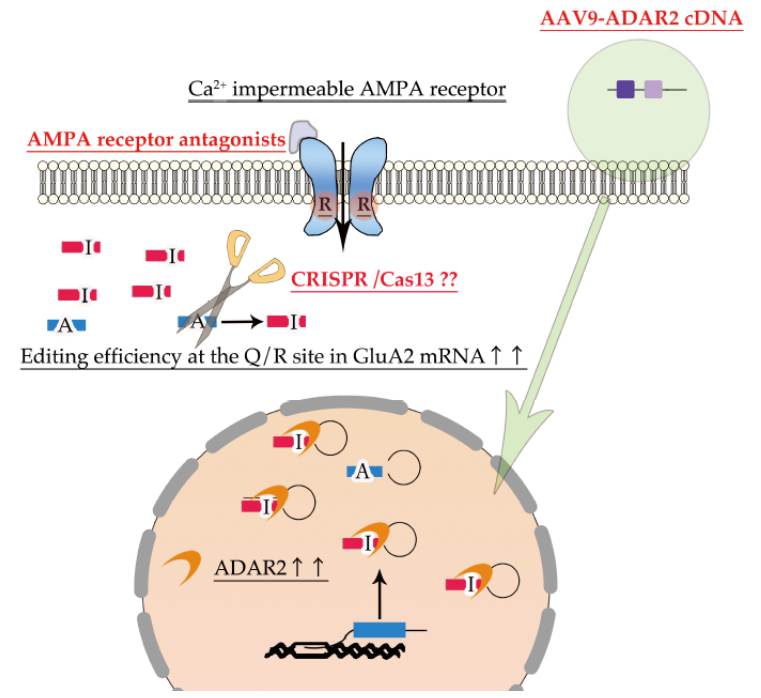
Figure 4. Promising therapy targeting dysregulation of ADAR2 RNA editing. AMPA receptor antagonists are potential therapeutic drugs for normalizing excessive Ca 2+ influx through Ca 2+ -permeable AMPA receptors. Delivery of ADAR2 cDNA to motor neurons using the adeno-associated virus type 9 (AAV-9) vector is a therapeutic approach to improve the expression of ADAR2 in the degenerating neurons (green arrow). Furthermore, RNA base editing of unedited GluA2 using CRISPR-Cas13 could also be a potential therapeutic approach to increase the proportion of edited GluA2. As RNA base editing therapy have not been established, the question marks were added.